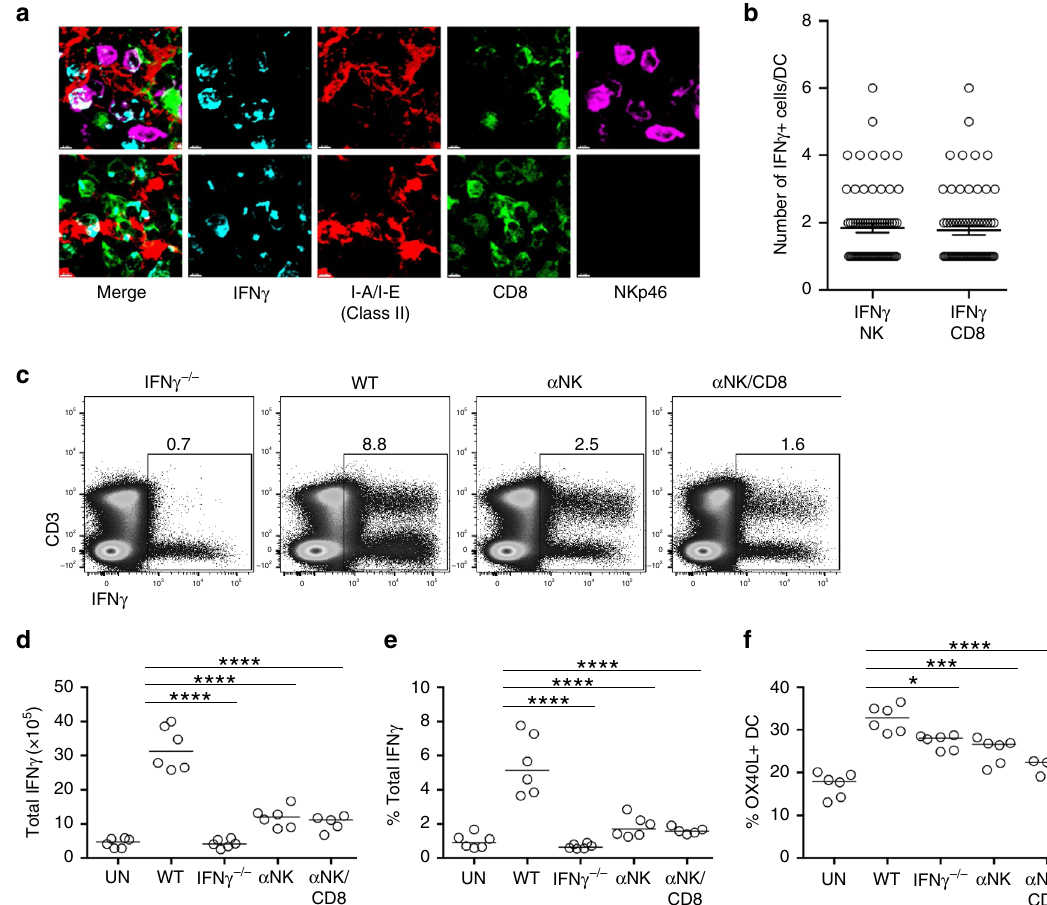
Fig. 6 NK cells are a critical source of IFN γ in vivo. To explore the spatial distribution of cells making IFN γ after infection with Lm , WT mice were infected with Lm and killed 24 h after infection (with treatment with brefeldin A 6 h before spleen harvest). Spleen sections were stained with anti-CD8 (green), Nkp46 (NK, magenta), I-A/I-E (DC, red) and IFN γ (cyan) antibodies. a Photographs are representative examples of IFN γ -producing CD8 and NK cells in close association with dendritic cells, scale bar: 4 μ m. Data are representative of 2 independent experiments. b Quanti fi cation of the number of IFN γ - producing CD8 T cells ( n = 67) and IFN γ -producing NK cells ( n = 70) in contact per dendritic cell ( n = 112) in 2 different spleens; mean and sem are shown, data were pooled from 2 independent experiments. To investigate the speci fi c role of early IFN γ production by NK cells or CD8 T cells, WT mice were given α NK1.1 or α NK1.1 and α CD8 monoclonal antibodies prior to the infection with Lm -2W1S. The IFN γ responses and OX40L expression on DC were assessed 24 h post infection and were compared to uninfected WT, infected WT and infected IFN γ − / − mice. c Representative fl ow cytometric plots showing total production of IFN γ at 24 h post infection. d Total numbers of IFN γ + cells. e Percentages of IFN γ + cells. f Proportion of dendritic cell- expressing OX40L at 24 h post infection. Data were pooled from 2 independent experiments ( n = 6 UN WT mice, n = 6 WT mice, n = 6 IFN γ − / − mice, n = 6 α NK WT mice, n = 5 α NK/CD8 WT mice). Statistical signi fi cance was tested by using ordinary one-way ANOVA with post hoc Tukey ’ s